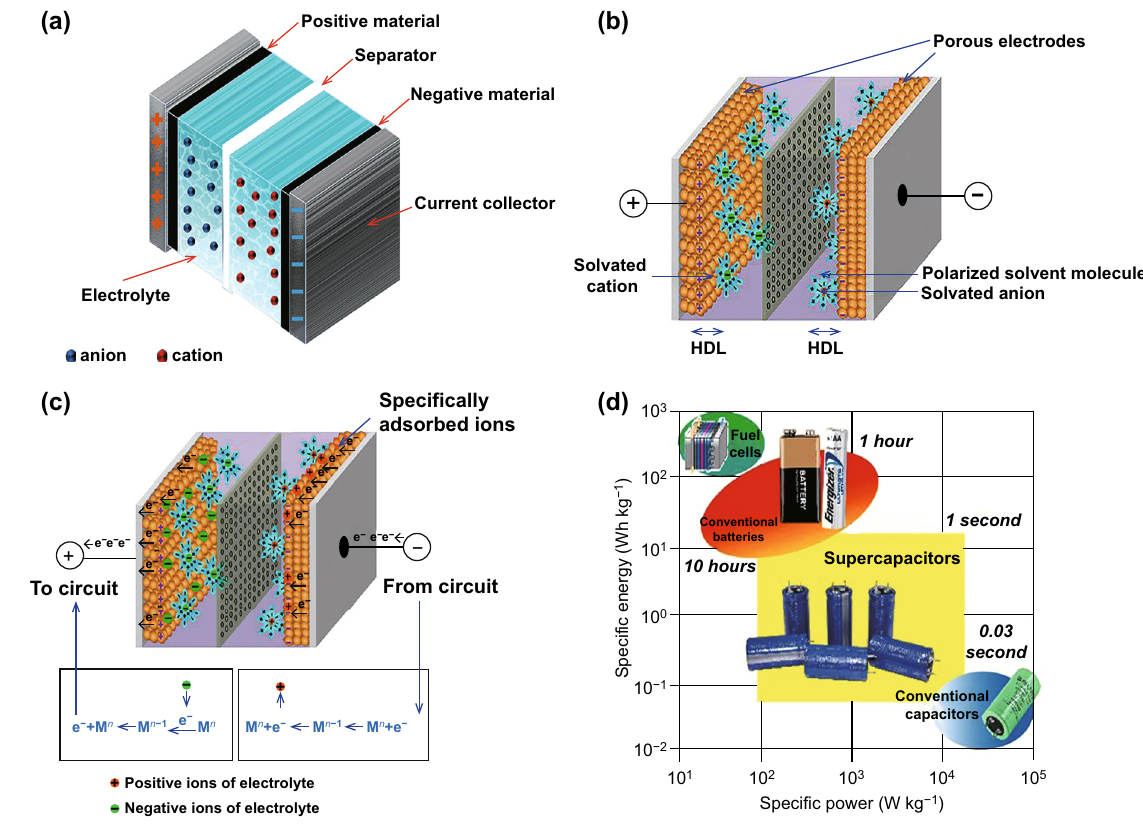
Fig. 1 a Schematic of an intact SC device. b Charge storage mechanisms of EDLCs and PCs. c Charge storage of PCs. Adapted with permission from Ref. [10]. d Specific power versus specific energy plot for various types of energy storage devices. Adapted with permission from Ref.